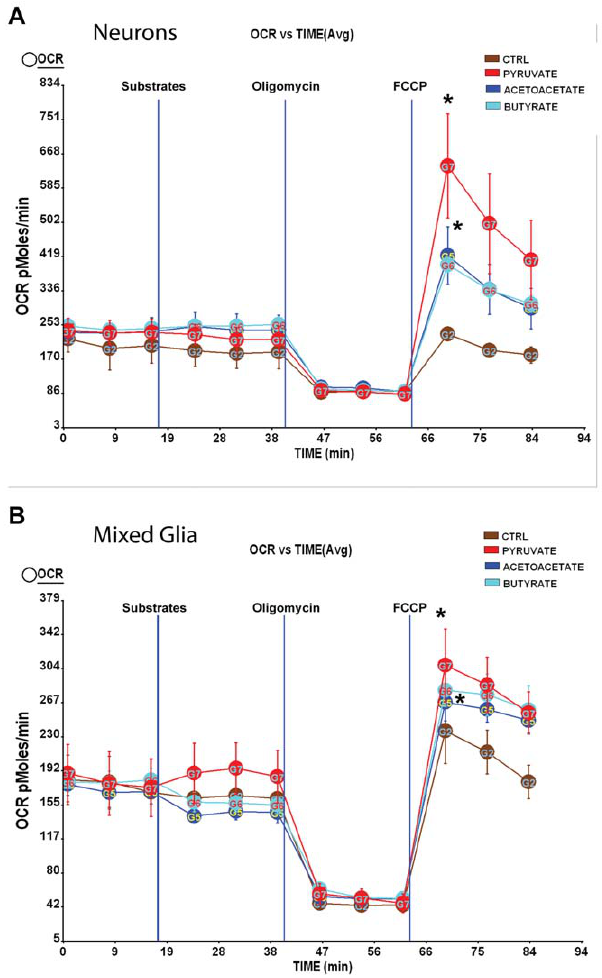
Figure 1. Utilization of ketone bodies as alternative fuel substrates in neurons and mixed glia. Primary hippocampal neurons from day 18 (E18) embryos of female Sprague-Dawley rats were cultured in Neurobasal medium + B27 supplement for 10 days prior to experiment. Mixed glia from day 18 (E18) embryos of female Sprague-Dawley rats were cultured in growth media (DMEM:F12 (1:1) + 10% FBS). Primary Oxygen consumption rate (OCR) was deter- mined using the Seahorse XF-24 Metabolic Flux analyzer. Vertical lines indicate time of addition of substrates and mitochondrial inhibitors. Substrates include vehicle control (Ctrl), pyruvate, acetoacetate and b